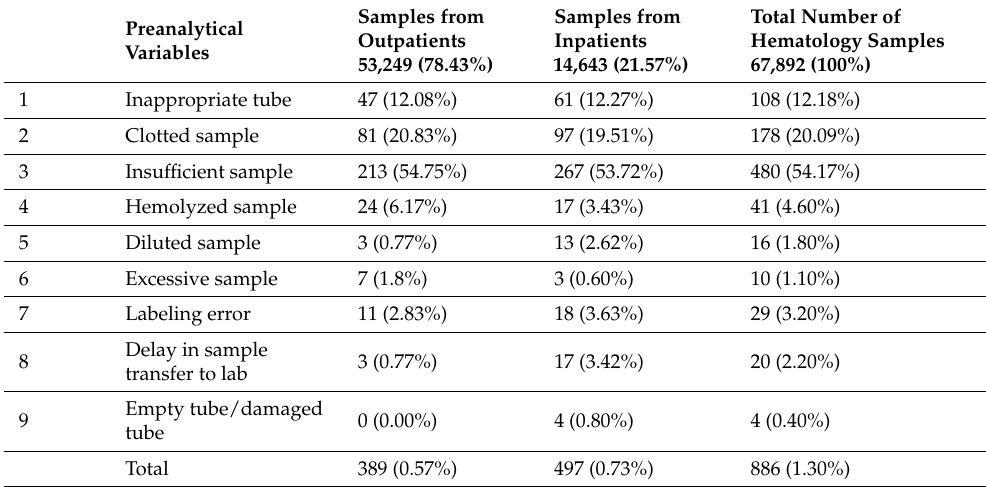
Figure 1. Frequency distribution of rejected samples across preanalytical variables from outpatients and inpatients.